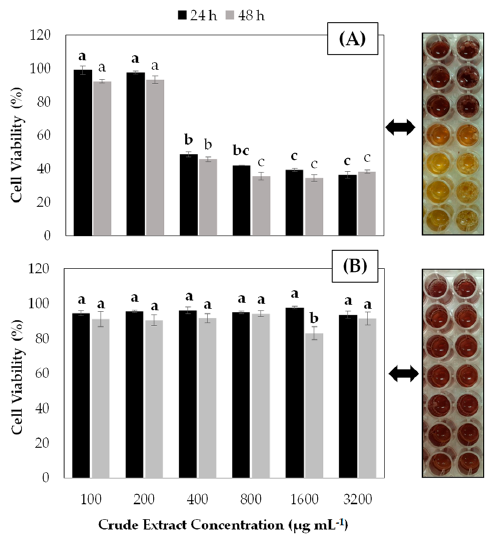
Figure 1. Effect of aqueous crude extracts of blueberry leaves ( A ) and fruits ( B ) on cell viability of the AGS gastric cancer cell line. Cell viability was measured after 24 and 48 h of extract incubation using the CellTiter 96 ® AQueous kit—One Solution Reagent assay. The percentage of viable cells was calculated in comparison to untreated control (water). Plotted values represent the mean of three independent experiments. Lower case letters (a–c) indicate significant differences among the treatments according to the Tukey test ( p ≤ 0.05). Error bars represent the standard error of the data set. On the right side of each graph the coloring reaction of this assay is included, where discoloration indicates loss of viability.